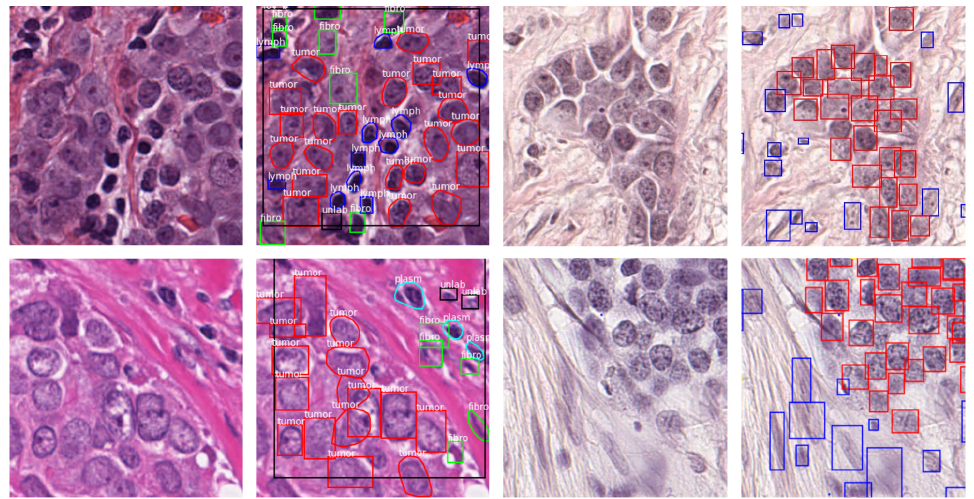
Figure 1. Sample images and annotations of the publicly available and local datasets. ( First Column ) Sample image of the publicly available dataset. ( Second Column ) Annotations as reported in the image text. ( Third Column ) Sample image of the local dataset. ( Fourth Column ) Annotations: red represents tumor nuclei; blue represents non-tumor